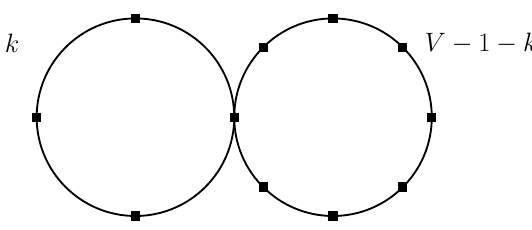
Figure 12 . The only form of connected diagrams with one vertex of degree 4, and the rest of degree 2. Excluding the vertex of degree 4, there are k vertices on one cycle, and V − 1 − k on the